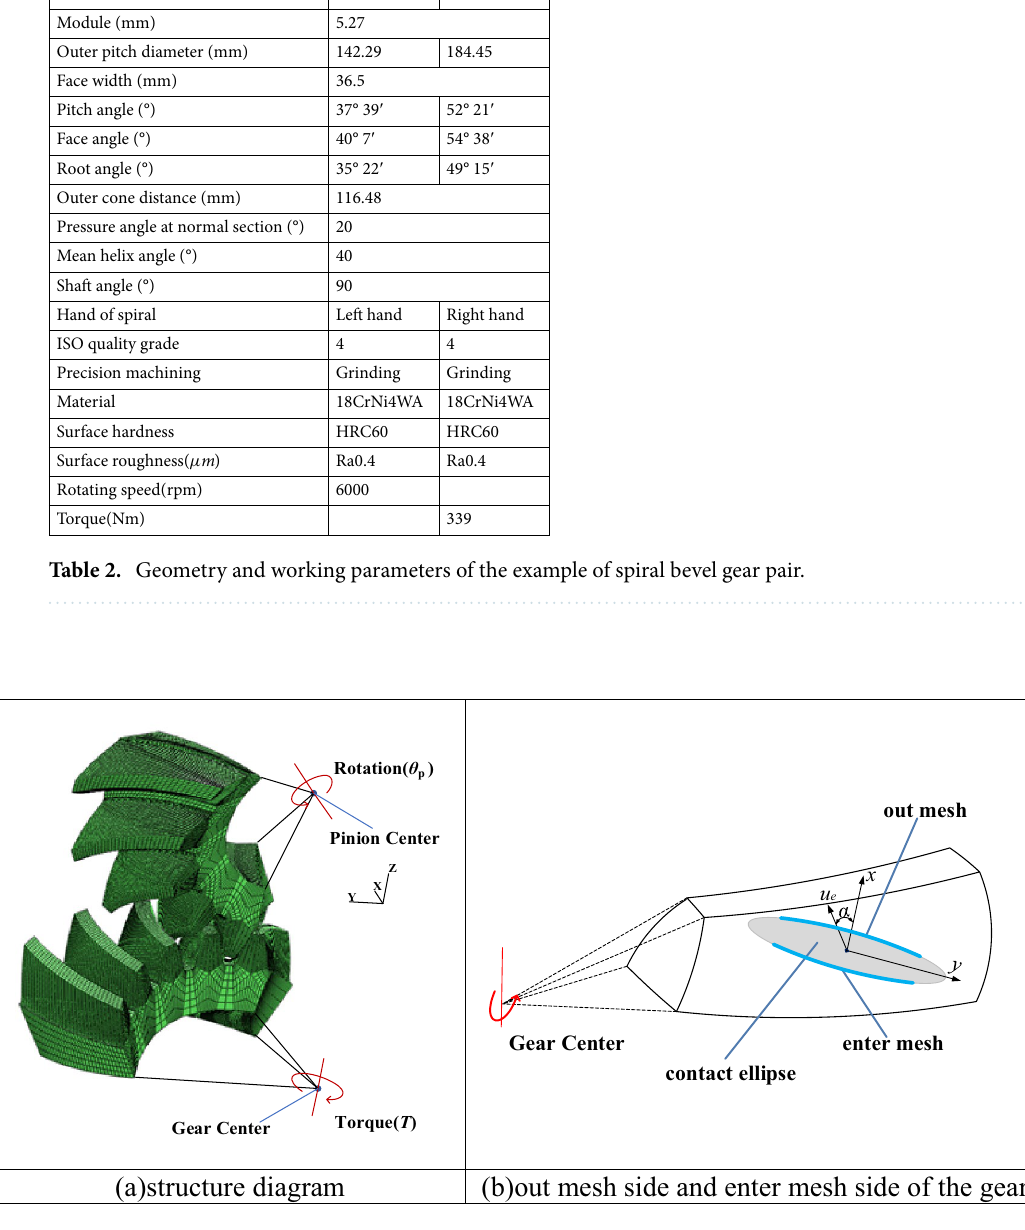
Figure 2. Structure diagram of spiral bevel